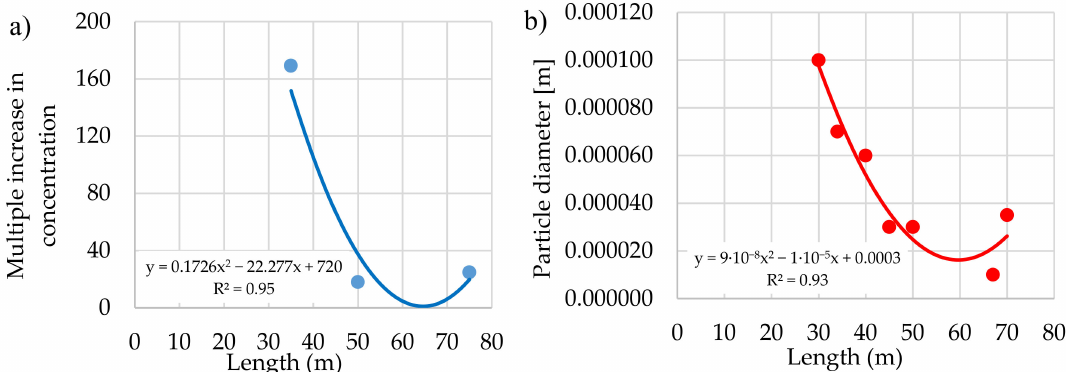
Figure 16. Comparisons of the concentration and the particle diameter of coarse aerosols depending on the length of the underground excavation at the height above the floor 1.55 m: ( a ) in situ measurements, ( b ) CFD calculations.